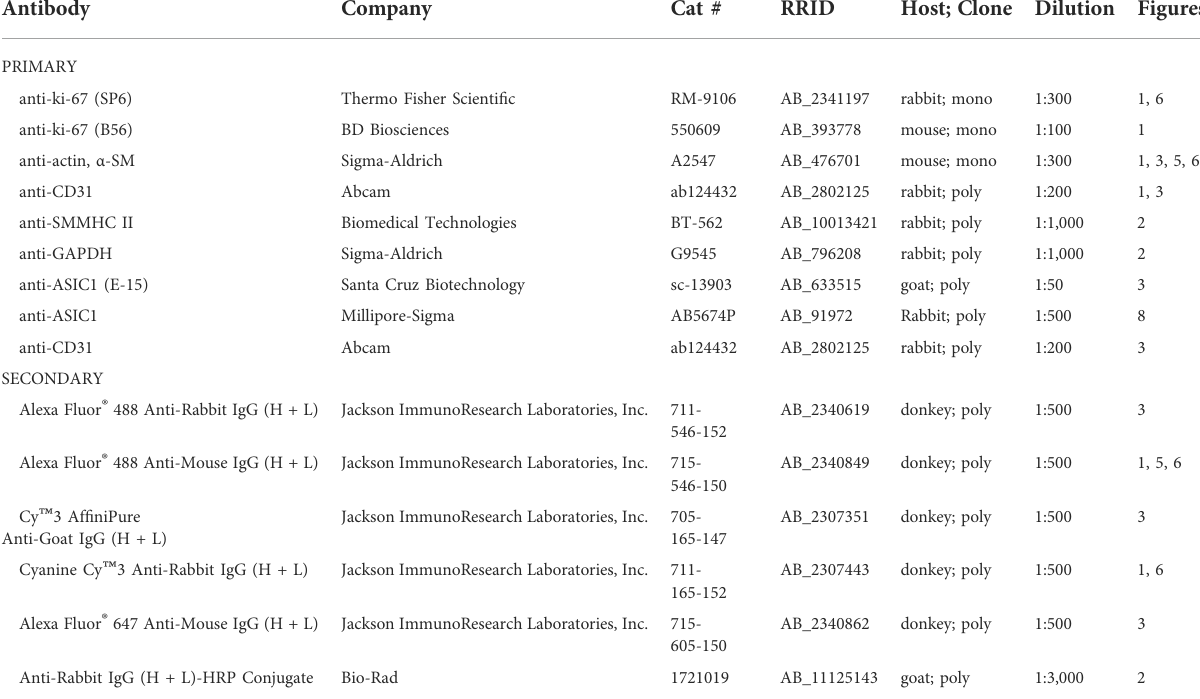
TABLE 2 List of primary and secondary antibodies used for immuno fl uorescence and western blot analysis.